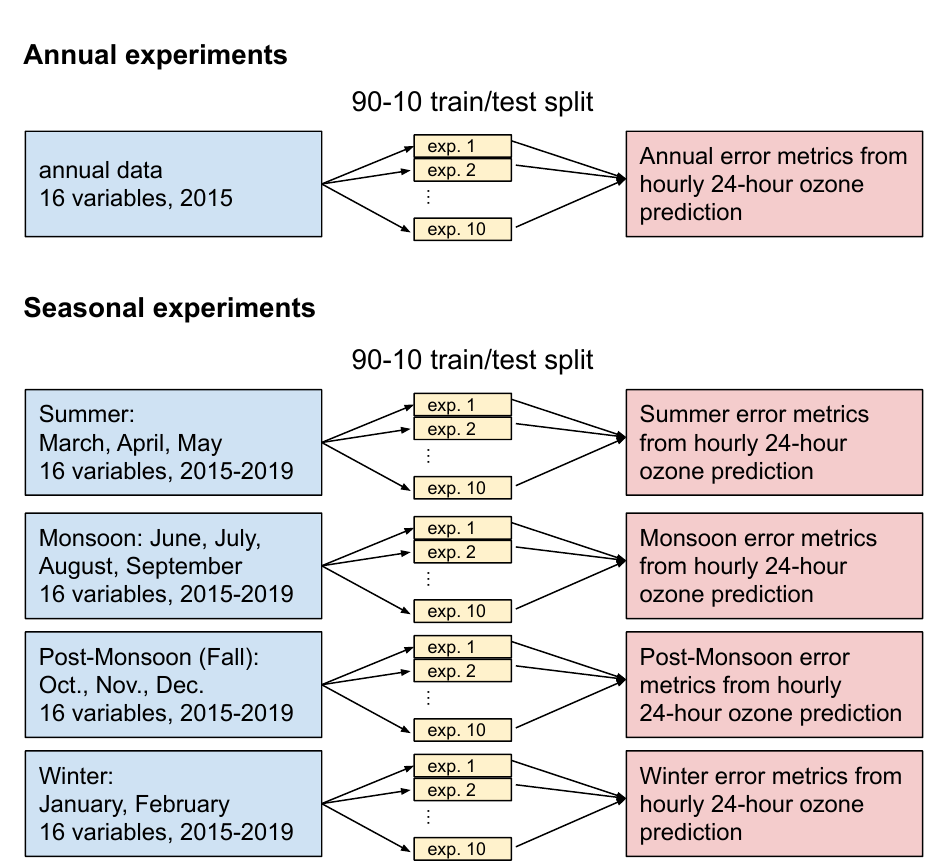
Figure 1. Diagram of the experimental design. This process was repeated for all machine learning methods tested in this